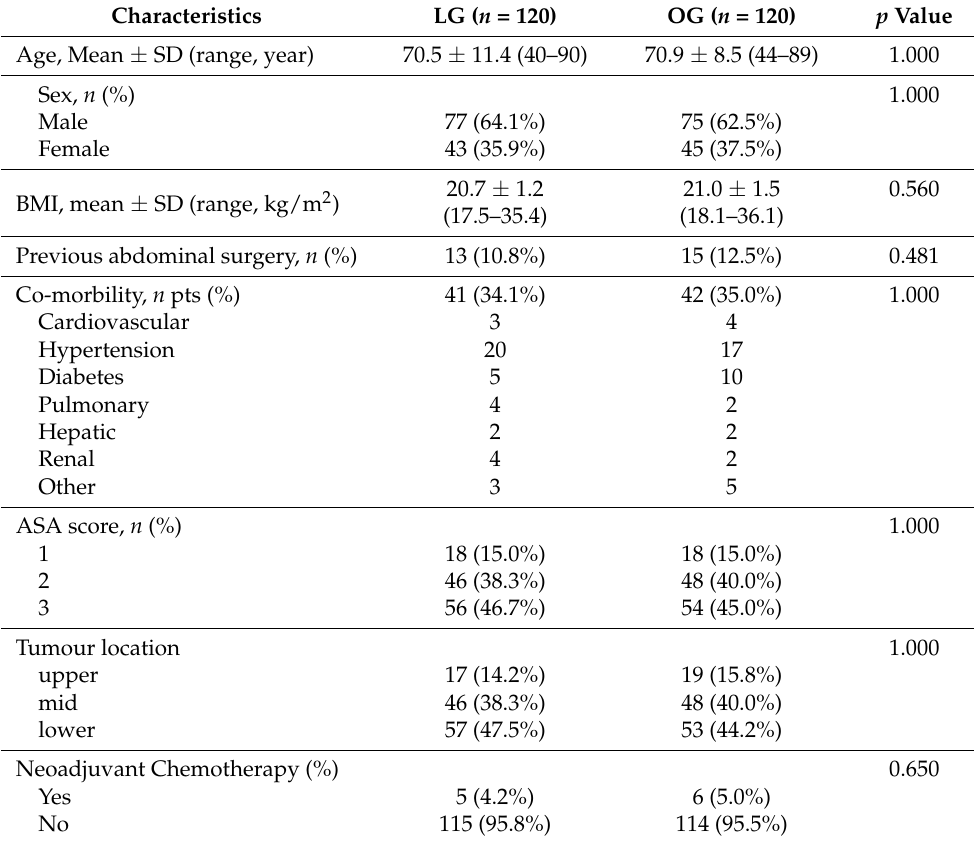
Table 1. Patients’ characteristics.